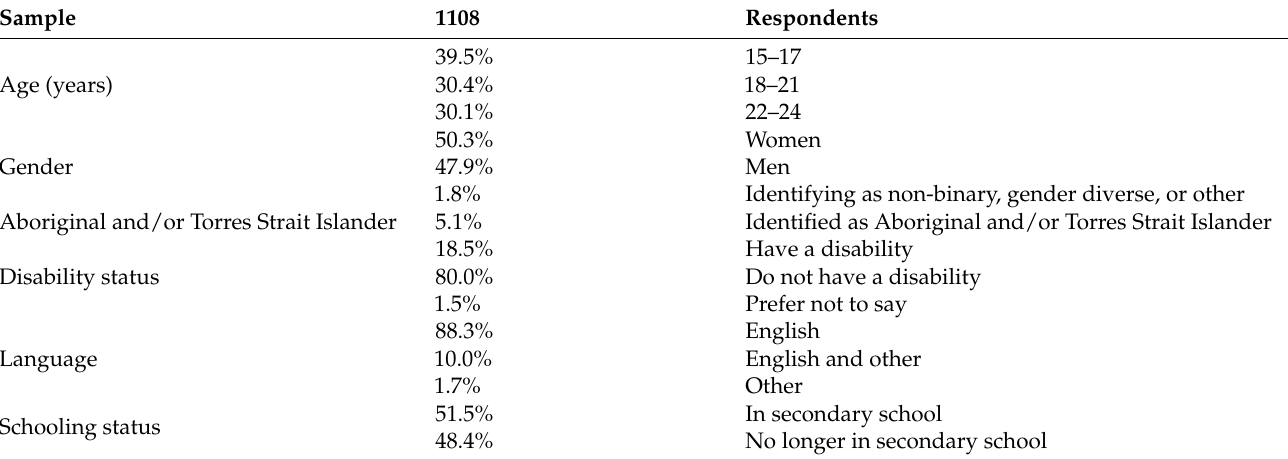
Table 1. Survey respondent